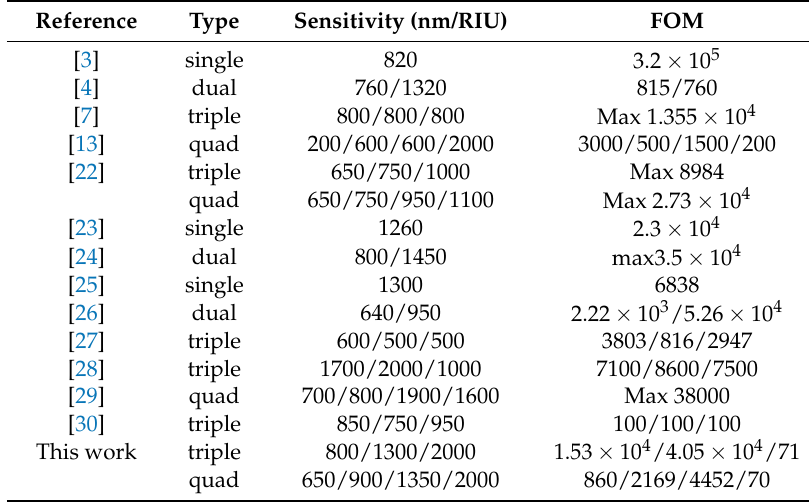
Table 1. The comparison of the proposed sensors and other recent similar structures in the